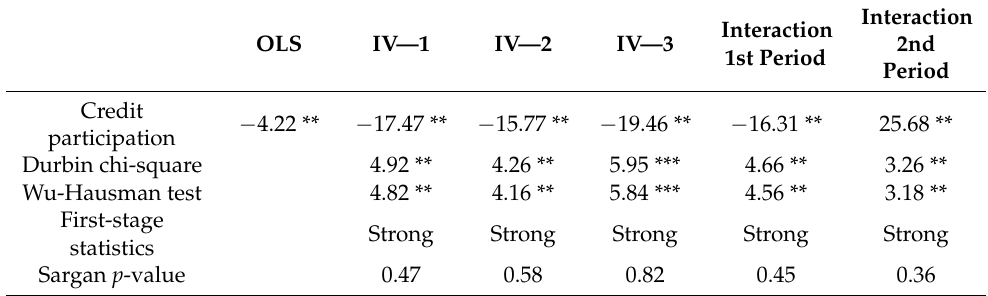
Table 4. Parameter estimates for farmers’ market participation and diagnostic